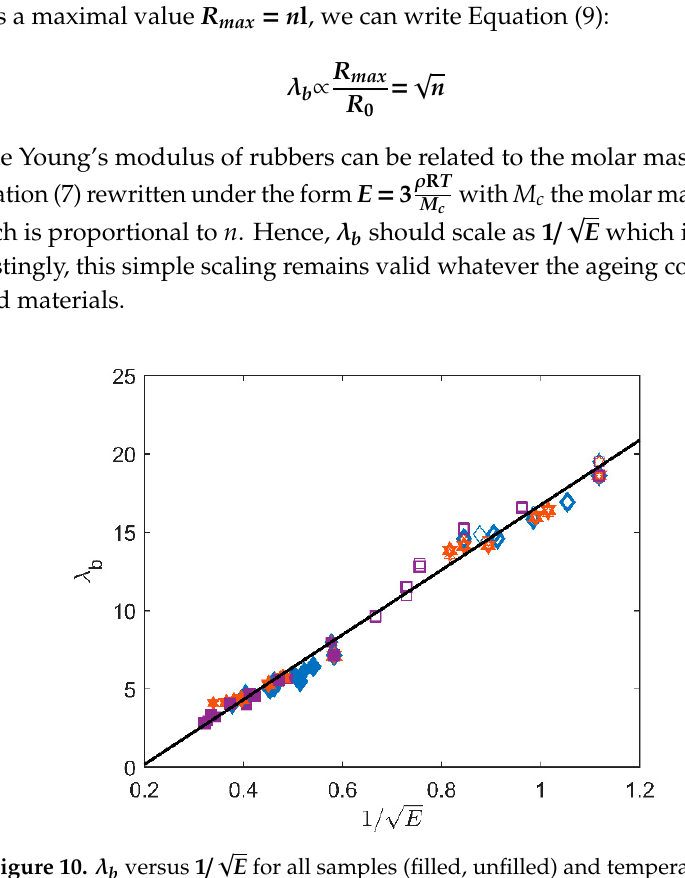
Figure 9. Young’s modulus (E) versus hardness shore A for all samples (filled, unfilled) and temperatures.